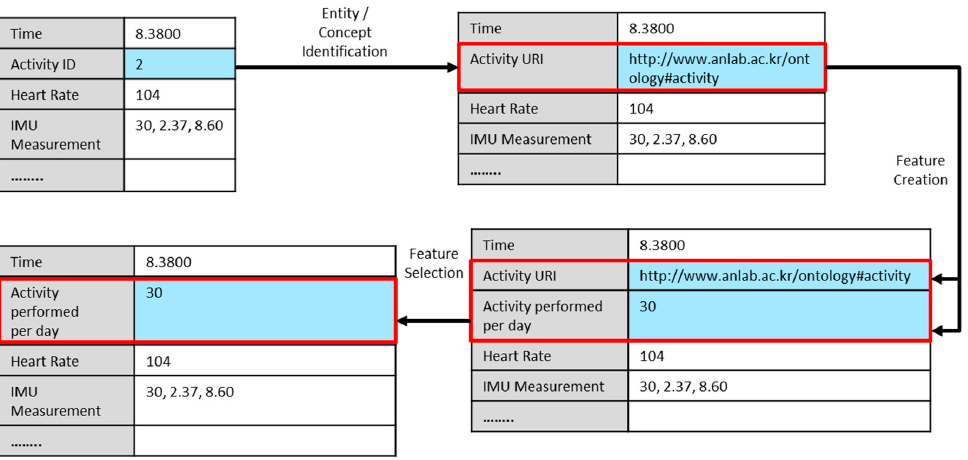
Figure 5. Example of feature selection from linked semantic data.